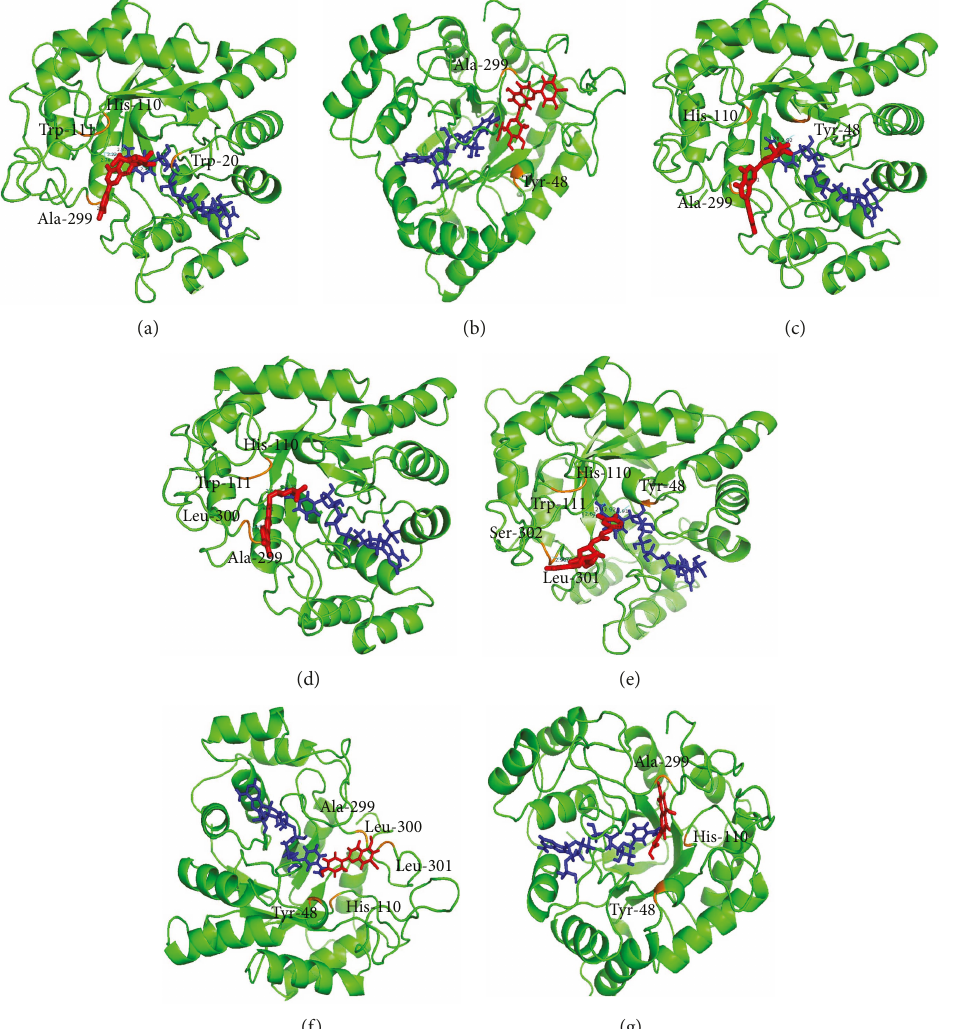
Figure 3: Docking models of apigenin-7- O - β -D-glucoside (a), luteolin-7- O - β -D-glucoside (b), apigenin-7- O - β -D-glucuronide (c), luteolin- 7- O - β -D-glucuronide (d), 3,5- O -di-ca ff eoylquinic acid (e), apigenin (f), and luteolin (g). The structure of aldose reductase is in green; the structures of the ligands are in red; the interactions of the residues with the ligands are shown in